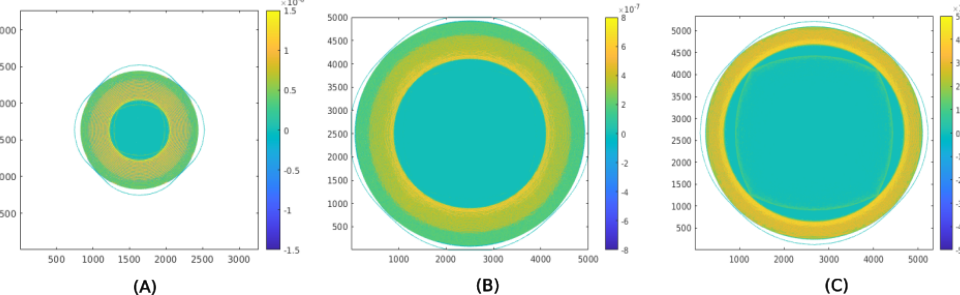
Figure 12. Absolute error between the CPU (double precision in serial) vs. the GPU (single precision) for the open space propagation at the last Time-step at 2.45 ( A ), 5.00 GHz ( B ), and 20.00 GHz ( C ).